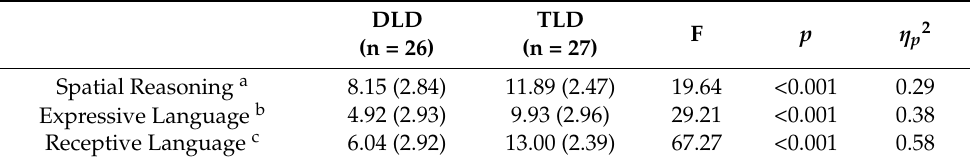
Table 2. Comparison of mean (SD) scaled scores from cognitive and language tasks by Developmental Language Disorder (DLD) group and Typical Language Developed (TLD)